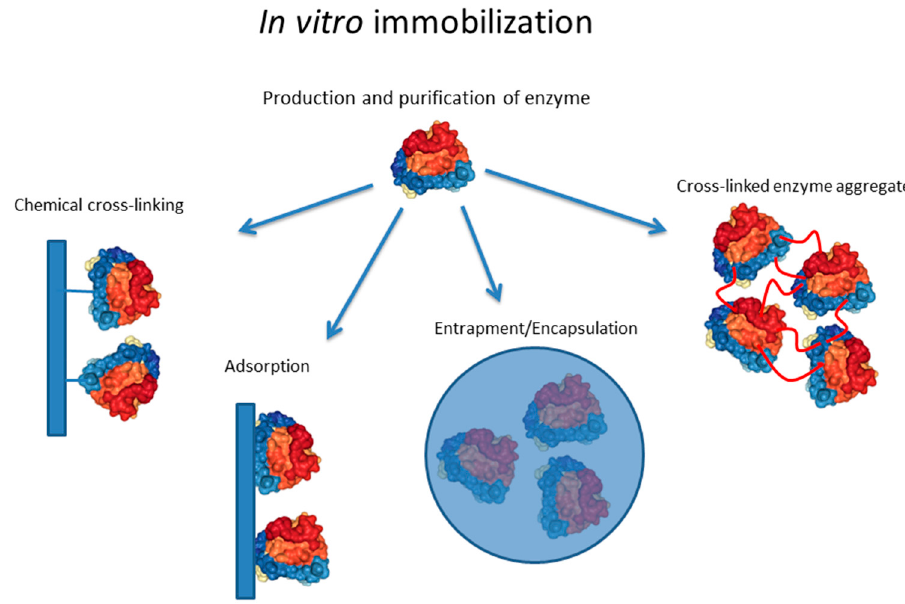
Figure 1. General methods for in vitro immobilization. The crystal structure (1TCC) of lipase B from Candida antarctica is depicted.